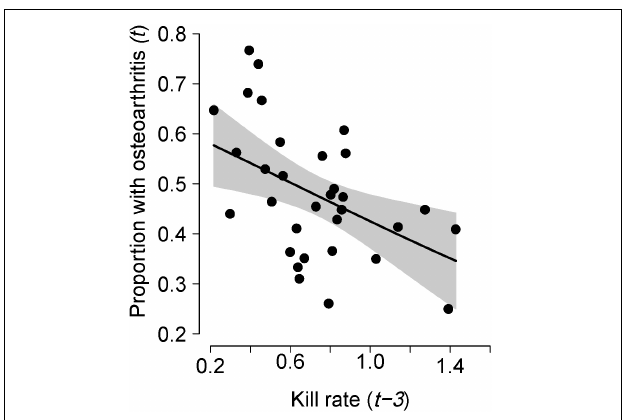
FIGURE 4 | Proportion of moose exhibiting osteoarthritis that died (from all causes) in year t in relationship to the per capita kill rate by wolves in year t –3. Each point represents a year ( t ) between 1979–2010. The line indicates a predicted value from a generalized linear model with two predictor variables, kill rate ( t-3 ) and proportion of senescent moose in the population ( t ), where the proportion of senescent moose was fixed at the median value observed during the 33-year study period. Gray areas indicate 95% confidence intervals. The relationship with the proportion of moose exhibiting osteoarthritis and kill rates ( t-2 ) is similar to the one shown